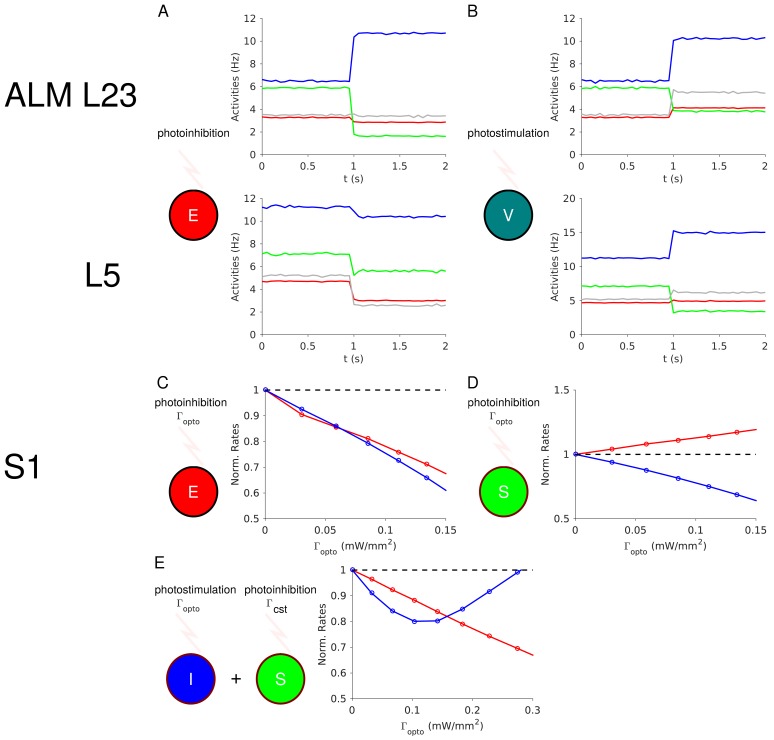
Predictions of the theory.(A) In ALM layer 2/3, the activity of the PV population decreases upon photoinhibition of the PCs. (B) In ALM layer 2/3, photostimulation of VIP neurons increases the activity of the PV population. (C) In S1, PV and PC activity decrease proportionally upon photoinhibition of the latter. (D) In S1, the PC and PV responses are not proportional upon photoinhibition of the SOM population. (E) In S1, upon photostimulation of PV neurons and photoinhibition of the SOM population with a constant input, the PV response is paradoxical but PC and PV responses are no longer proportional.